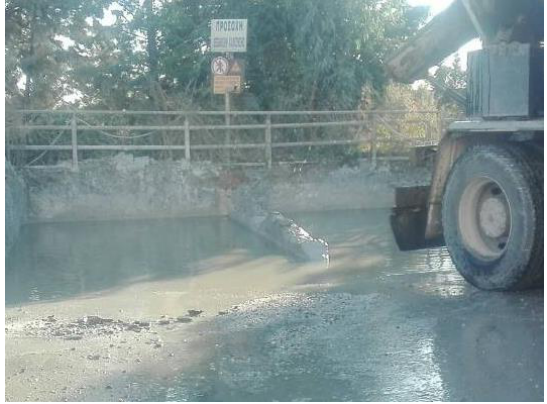
Figure 2. Sedimentation tank for the water-washing of the trucks.